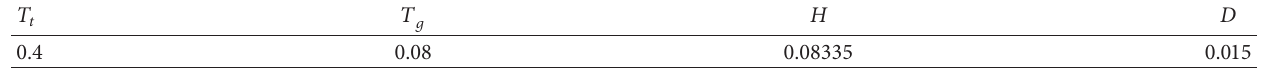
Table 1: Parameters of single-zone microgrid system with non-reheat generators.